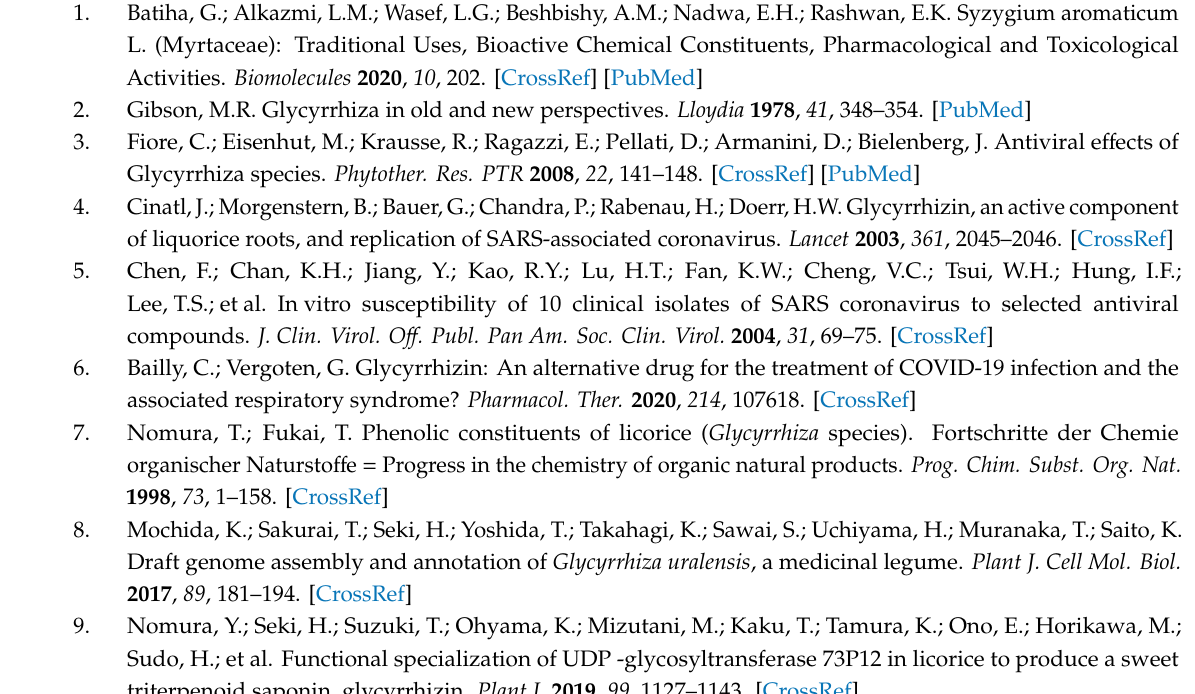
Table S1: All the Cq Values under di ff erent experimental conditions in G. uralensis , Table S2: All the Cq Values under di ff erent experimental conditions in G. inflata , Table S3: Cq values of candidate reference genes under di ff erent conditions in G. uralensis and G. inflata , Table S4: Stability of candidate reference genes under di ff erent conditions in G. uralensis , Table S5: Stability of candidate reference genes under di ff erent conditions in G. inflata , Table S6: Recommended reference genes for qRT-PCR analysis under di ff erent conditions in Leguminosae plants. Author Contributions: This research was designed by Y.L. (Yongqing Li), X.Z., and Y.W.; Y.L. (Yuping Li) and X.L. carried out the experiments; Y.L. (Yuping Li) performed data analysis; Z.W. prepared the hormonal treatment samples; Y.L. (Yuping Li) drafted the manuscript; and Y.L. (Yongqing Li), X.Z., and L.Y. revised the manuscript. All authors have read and agreed to the published version of the